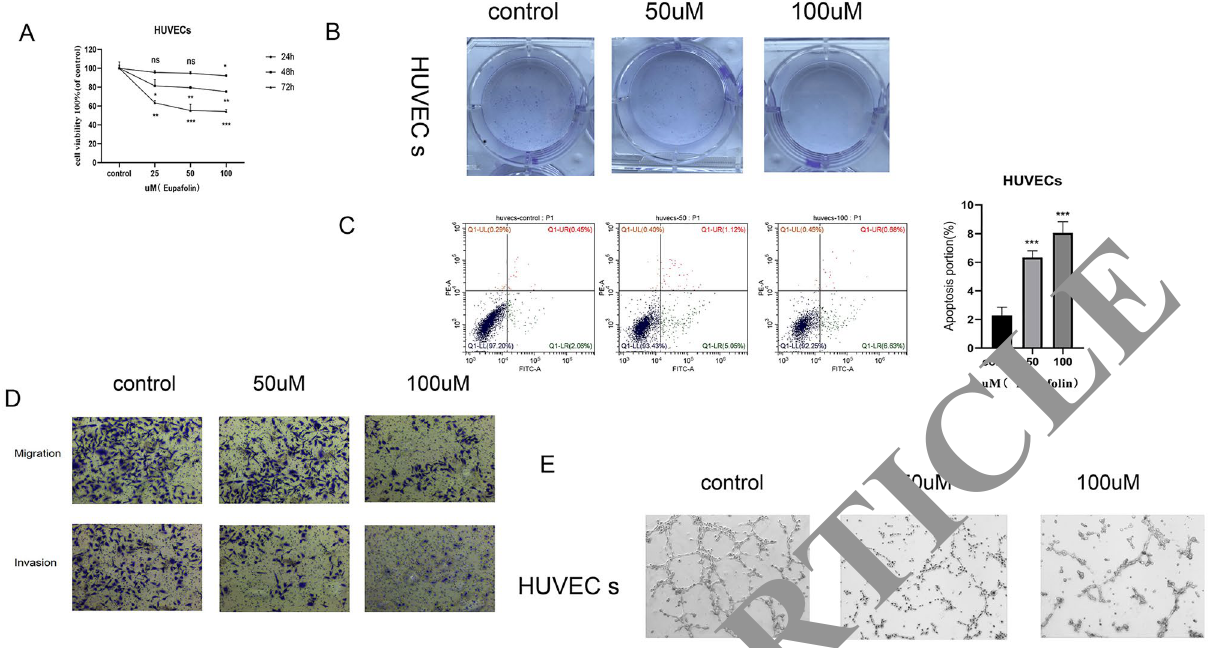
Figure 5. Anti-angiogenic activity of Eupafolin. ( A , B ) Human umbilical vein endothelial cells (HUVECs) were treated with Eupafolin at concentrations of 0, 25, 50 and 100 μM for 24, 48, and 72 h, respectively. Cell viability was evaluated by the CCK-8 assay and cell colony formation assay. ( C ) HUVECs were treated with Eupafolin at concentrations of 0, 50, and 100 μM for 24 h, and then subjected to apoptotic analysis by flow cytometry (lower panel). ( D ) HUVECs treated with Eupafolin at concentrations of 0, 10, and 20 mg/ml were subjected to the migration and invasion assay and observed at 24 h, respectively. ( E ) HUVECs treated with Eupafolin at concentrations of 0, 50, and 100 μM for 6 h were subjected to the tube formation assay. Data is representative of three independent experiments and expressed as mean ± SD. P > 0.05 indicates non-significance; ***P < 0.001; **P < 0.01; *P <